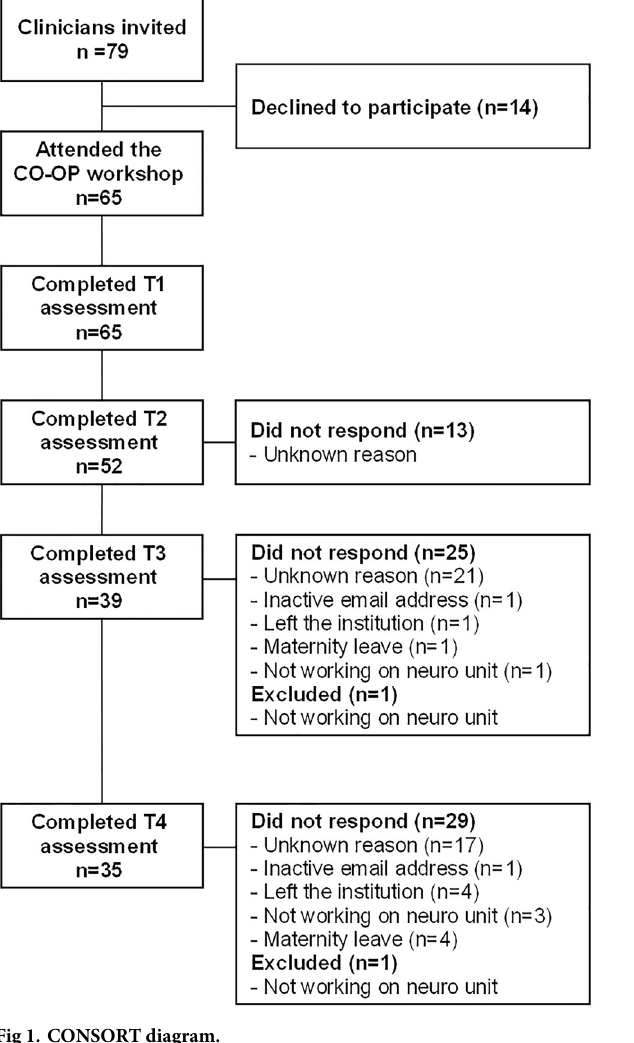
Fig 1. CONSORT diagram.